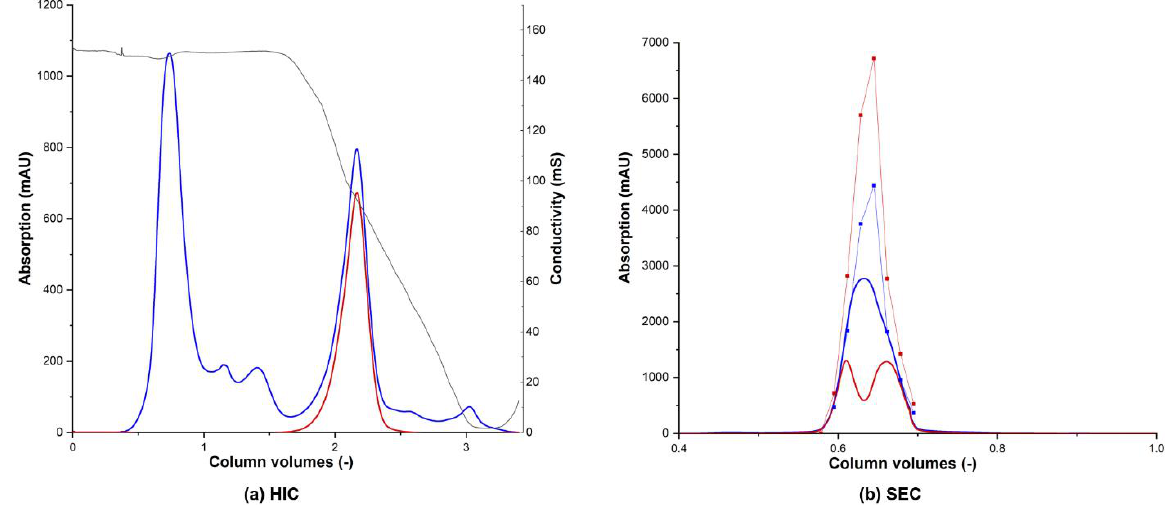
Figure 4. Purification of r Cab UPO 2 by hydrophobic interaction chromatography (HIC) ( a ) and size- exclusion chromatography (SEC) ( b ). Conductivity — , absorption was determined online (280 nm — , 420 nm — ) and offline (280 nm ∎ , 420 nm ∎ ).